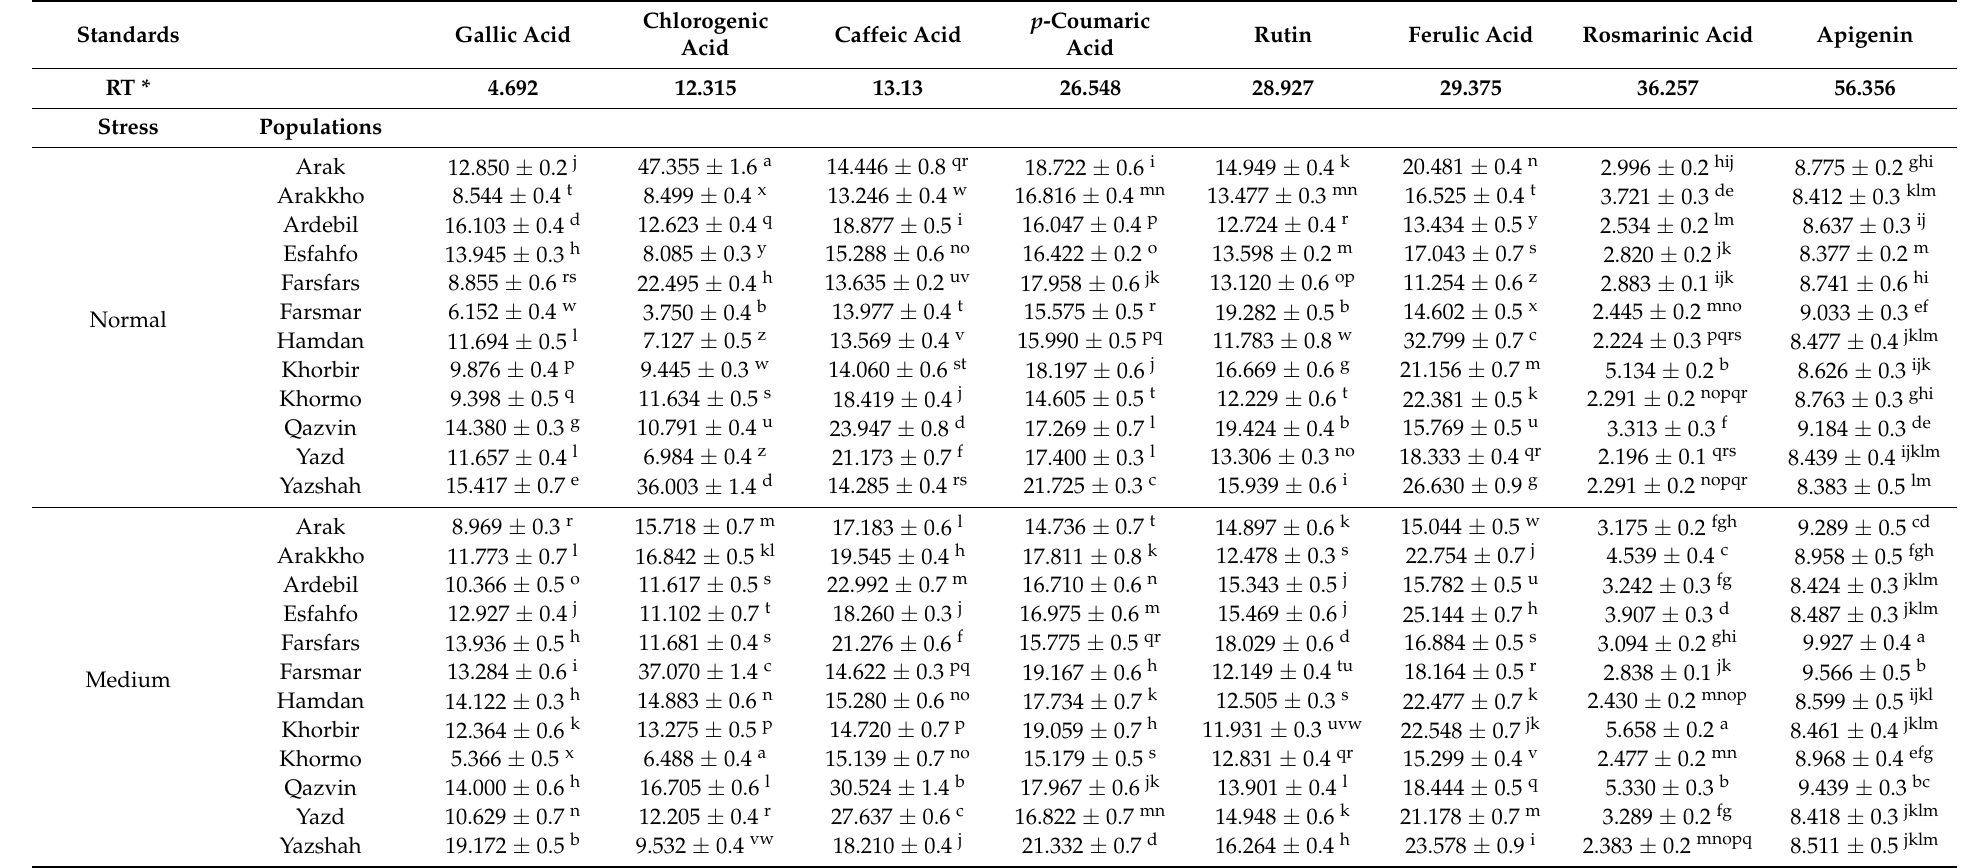
Table 3. Major phenolic and flavonoid compounds of studied Ajowan populations based on HPLC analysis. The values are expressed as mg/100 g of sample dry weight. The results are expressed as mean ±